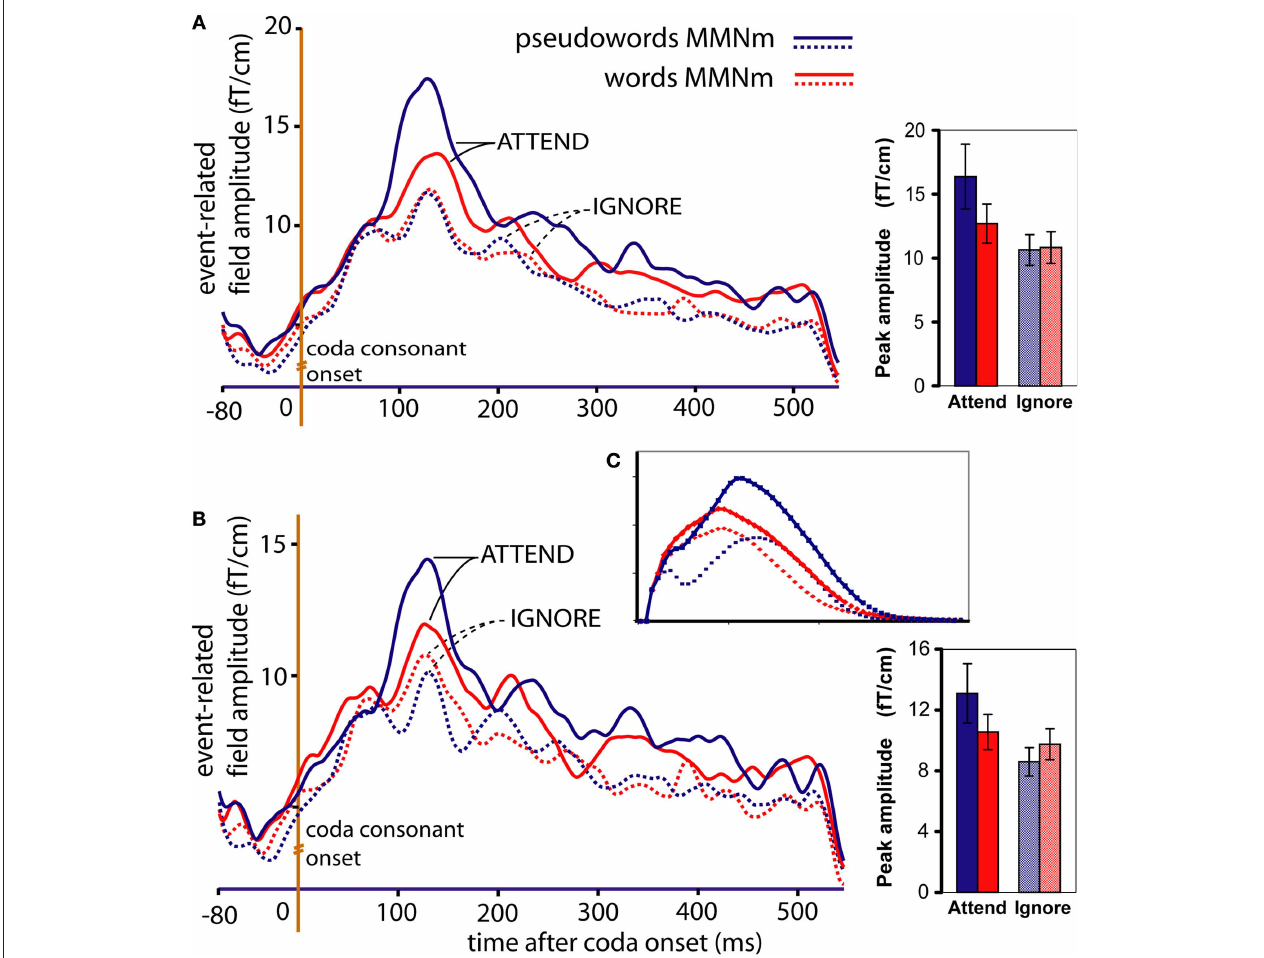
FIGURE 6 | Magnetic brain responses to words ([bajt], [pajp], in red) and pseudowords (*[bajp], *[pajt], in blue) in the two conditions (Attend: solid lines; Ignore: dotted lines). The curves plot local gradient vector amplitudes of the MMN averaged over (A) the eight loci exhibiting largest responses (refer to Figure 4 ), and (B) the subset of four superior (dorsal) high-amplitude locations.